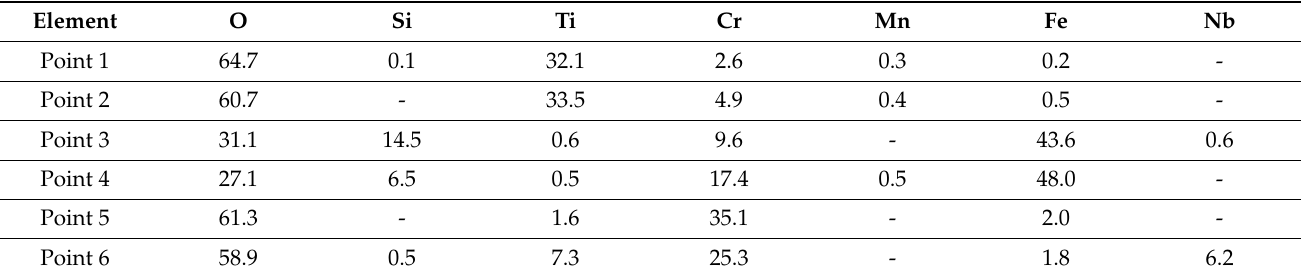
Table 1. EDX results (at.%) of areas indicated in Figure 5b,c.